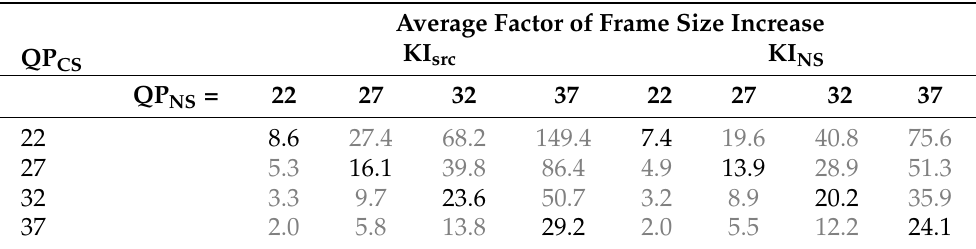
Table 1. Average factor with which size of inserted keyframe increases compared to the inter-frame that it